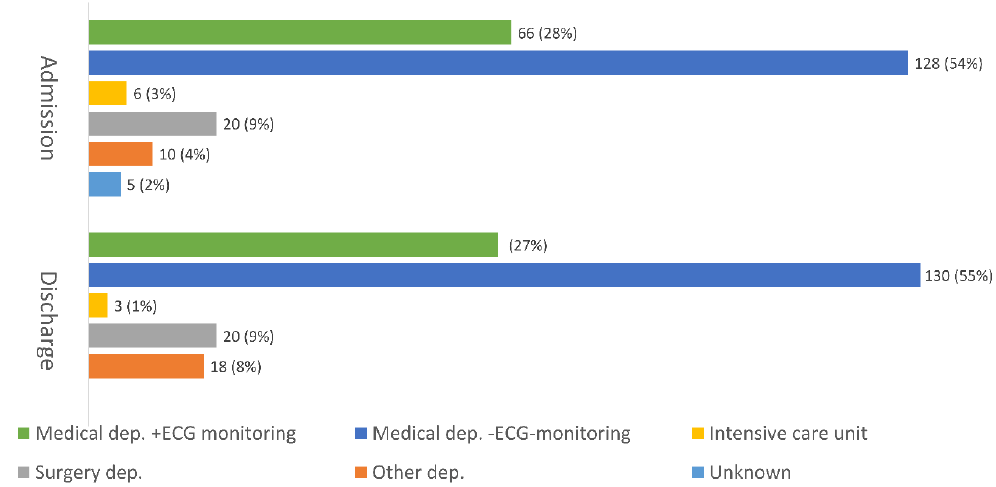
Figure 2. Departments of admission and of discharge among non-CD patients.